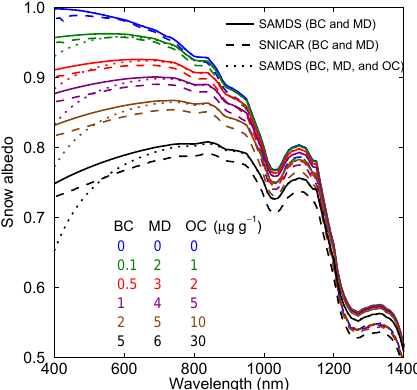
Figure 8. Spectral albedo of snow with different contaminants for a 60 ◦ solar zenith angle and a 100µm R eff . Solid and dashed lines show the SAMDS and SNICAR model predictions for BC and MD. Dotted lines show the SAMDS model predictions for all ILAPs, including BC, MD, and